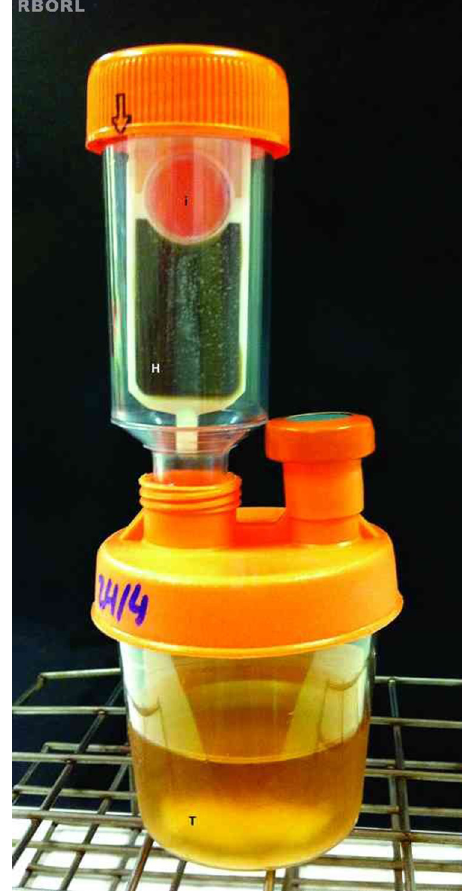
Figure 5 System after the end of the incubation period. Nasal packing (T) inside the container of supplemented broth, CO 2 indicator (i) with a strong pink color due to the presence of micro-organisms and chocolate agar medium (H) with the pres- ence of bacterial